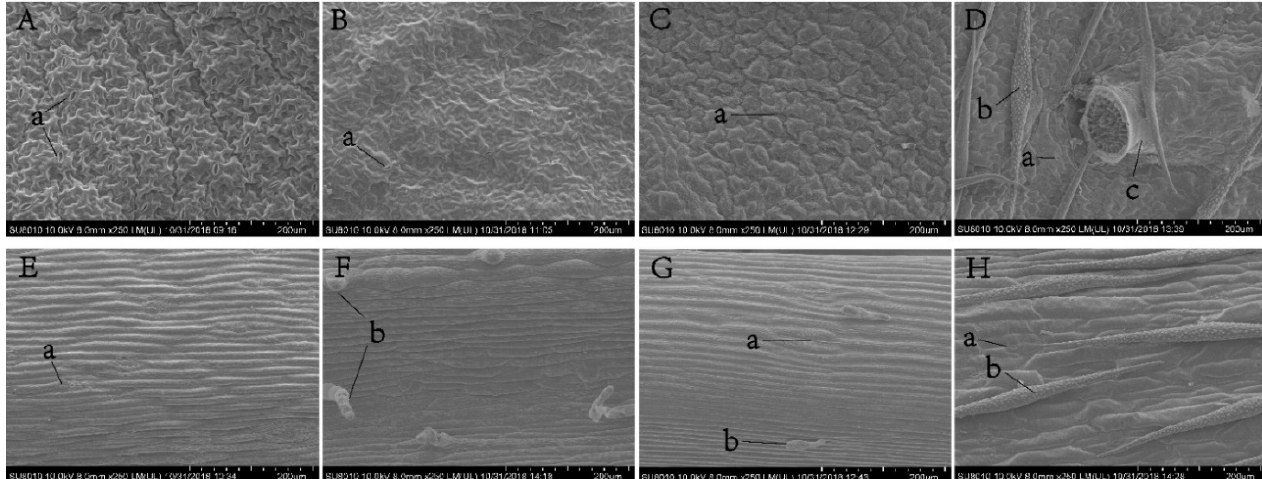
Figure 4. The surface character of four plant species: ( A ) coriander leaf; ( B ) marigold leaf; ( C ) alfalfa leaf; ( D ) sweet alyssum leaf; ( E ) coriander stem; ( F ) marigold stem; ( G ) alfalfa stem; ( H ) sweet alyssum stem; a: Stomata; b: Trichomes; c. Orius sauteri eggs in sweet alyssum leaves; magnification: 250×.